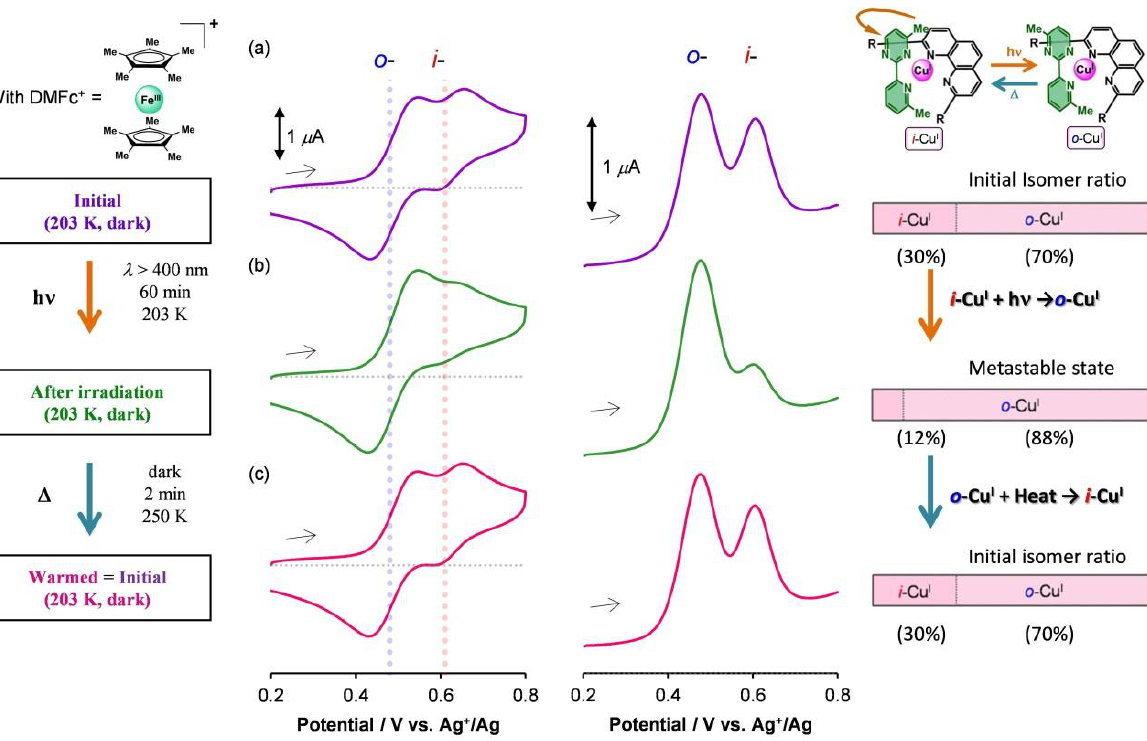
(0.45 mM) 4 ( a ) at 203 K in the 4